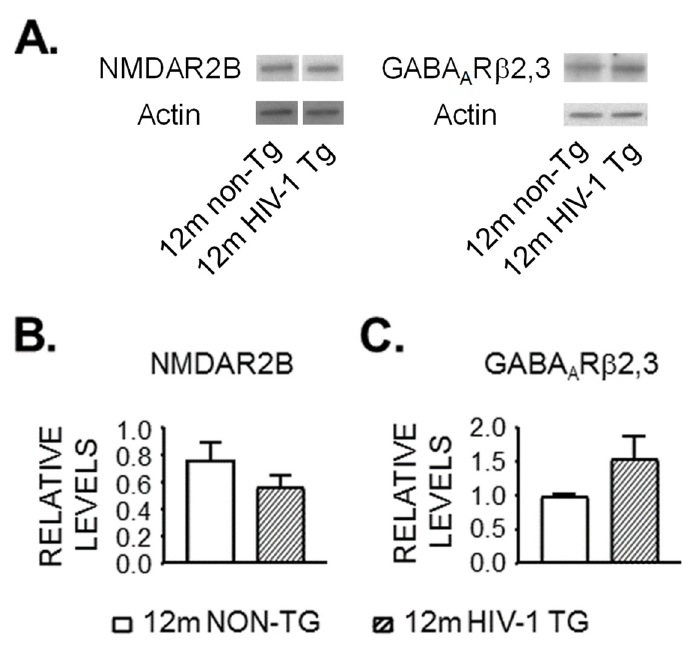
Figure 3. NMDAR2B and GABA A R protein levels are unaltered in the HIV-exposed striatum of aging rats. Protein levels were measured in the caudate-putamen dissected from 12mo-old HIV-1 Tg (hatched bars, n = 7–8) and non-Tg rats (open bars, n = 7–8). ( A ) Representative western blots of NMDAR2B and GABA A R β 2,3 protein. For GABA A R staining and respective actin staining, membranes were first probed for GABA A R protein, then stripped and re-probed for actin, For the representative NMDAR bands, the samples were run on the same gel, but were not side-by-side; i.e., the bands shown were cropped from two different areas of the same membrane. Supplementary Figure S2 shows the full blots for the representative samples. ( B , C ) Bar graphs showing relative levels of NMDAR2B ( B ) and GABA A R β 2,3 ( C ) normalized to β -actin protein.